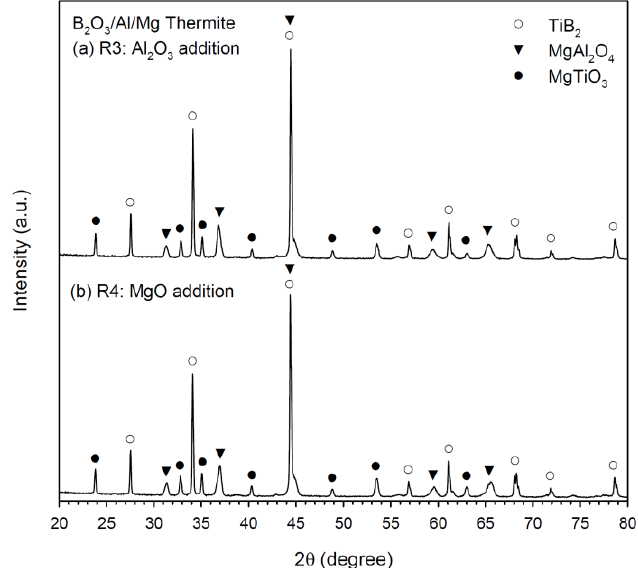
Figure 6. XRD patterns of TiB 2 /MgAl 2 O 4 composites obtained from SHS reactions of ( a ) Equation (3) and ( b ) Equation (4).